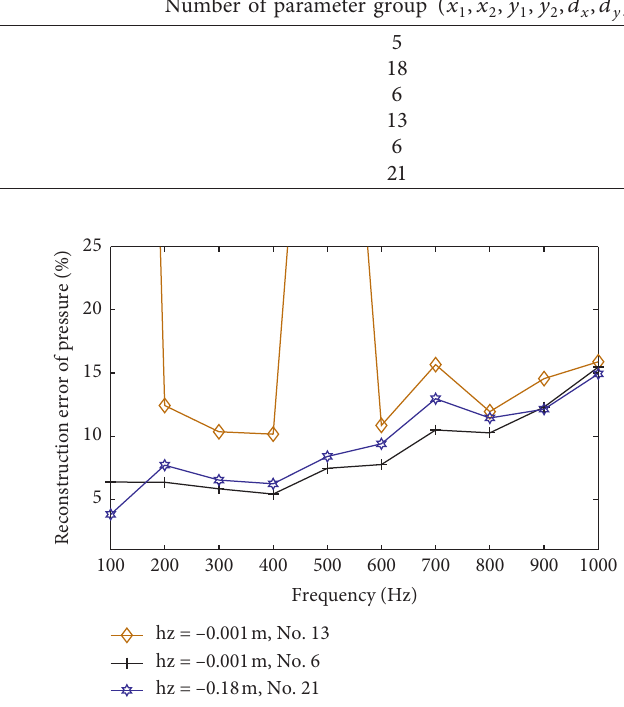
Figure 10: The reconstruction error of pressure versus the fre- quency with a piece of sponge as the reflecting